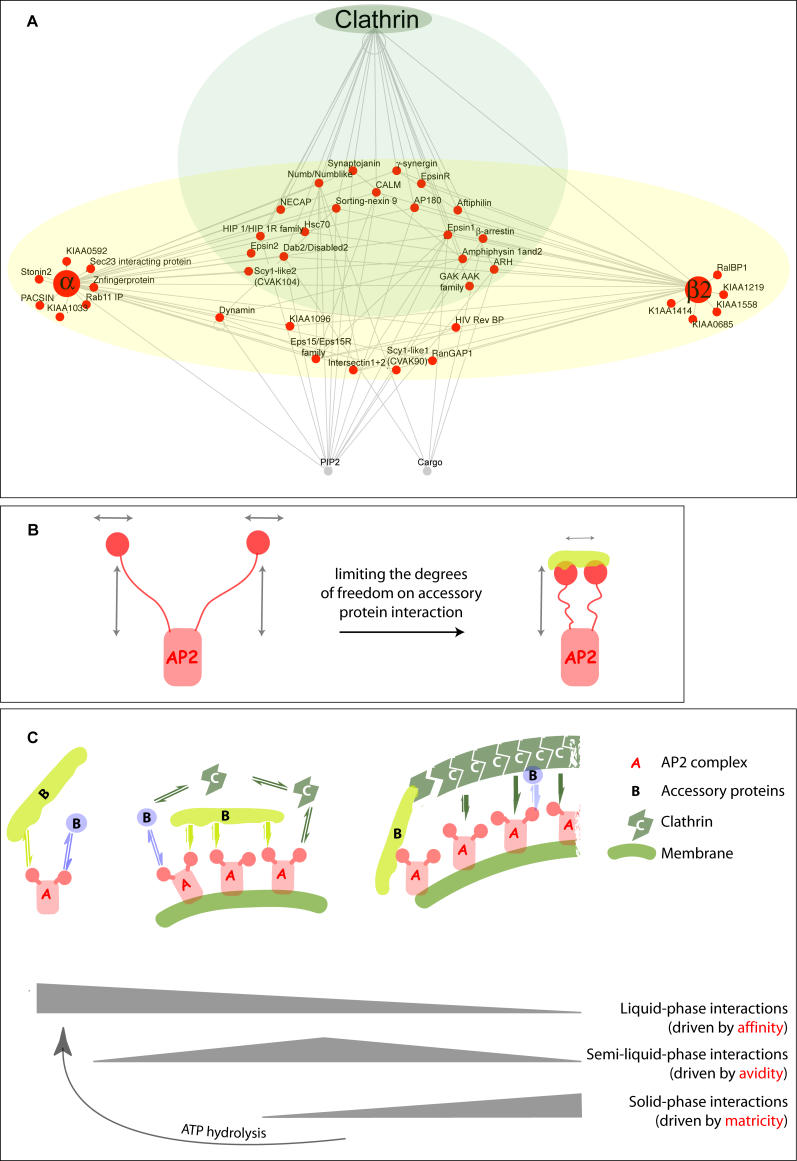
Network Dynamics(A) Network of protein interactions of AP2 appendages and clathrin. The α- and β2-appendage interaction data are from our mass spectrometry analysis and from the literature. The AP2 hub (yellow shaded area) is made up of 2-sub-hubs that increase the interactome repertoire (side arms) but for the majority of proteins they increase the interaction avidity (central circle). As the network matures and clathrin is recruited, many of the previous interactors become clathrin interactors (green shaded area). Of the remaining proteins we only know of a few that do not bind to clathrin, while others have simply not been tested.(B) Limiting the mobility of appendage domains by interactions of both domains with the same accessory protein.(C) The changing environment of adaptor protein complexes, A, in CCV formation, showing the gradual movement from simple affinity based interactions with accessory proteins, B, to avidity based interactions, once adaptors are recruited to the membrane. As the coated pit matures and clathrin, C, polymerises into a matrix then accessory proteins that cannot bind directly to clathrin are displaced to the edge where the pit is still growing. ATP hydrolysis is needed to depolymerise clathrin and re-prime the system.